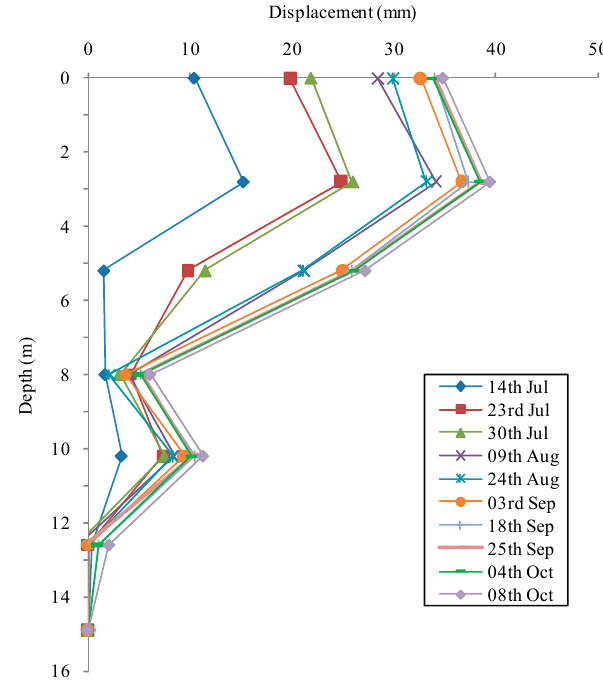
Figure 9. Borehole displacements at the lower part of the debris flow site [49].